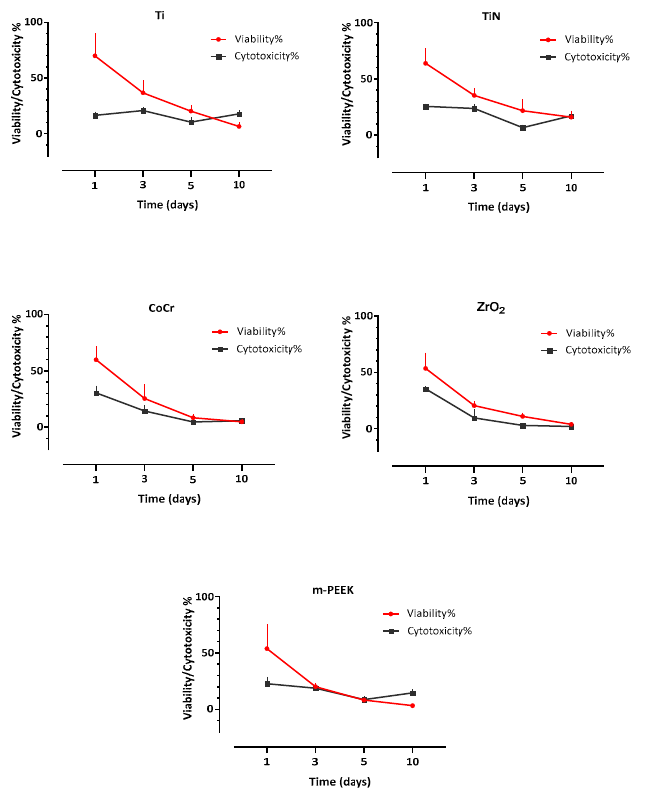
Figure 8. A line plot showing a nonsignificant positive correlation for Ti, TiN, and m-PEEK and a significant positive correlation of CoCr ( p = 0.004) and ZrO2 ( p = 0.008) between viability and cytotoxicity over 10 days for HGKC.